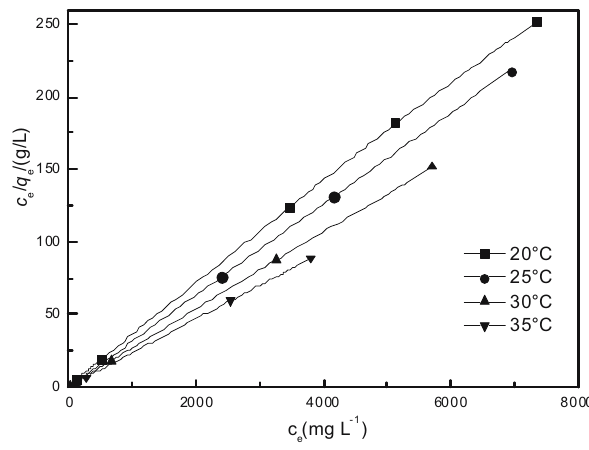
Table 2. The detailed analysis of the correlation coe ffi cient R 2 values showed that the Langmuir model ( 0.9993 – 0.9999 ) fi t the experimental data better than the Freundlich model ( 0.8233 – 0.9230 ) at di ff erent tempera - tures. From Table 2, it is also clear that the q increased when the temperature increased, once again indicating the adsorption was an endothermic process.